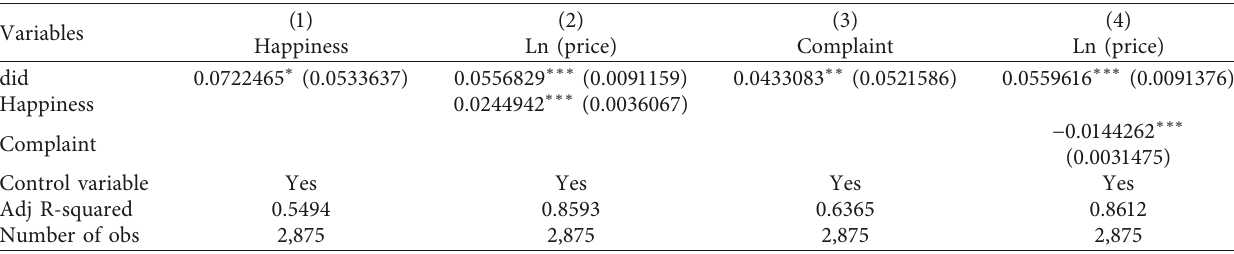
Table 6: Mechanism of action analysis results.